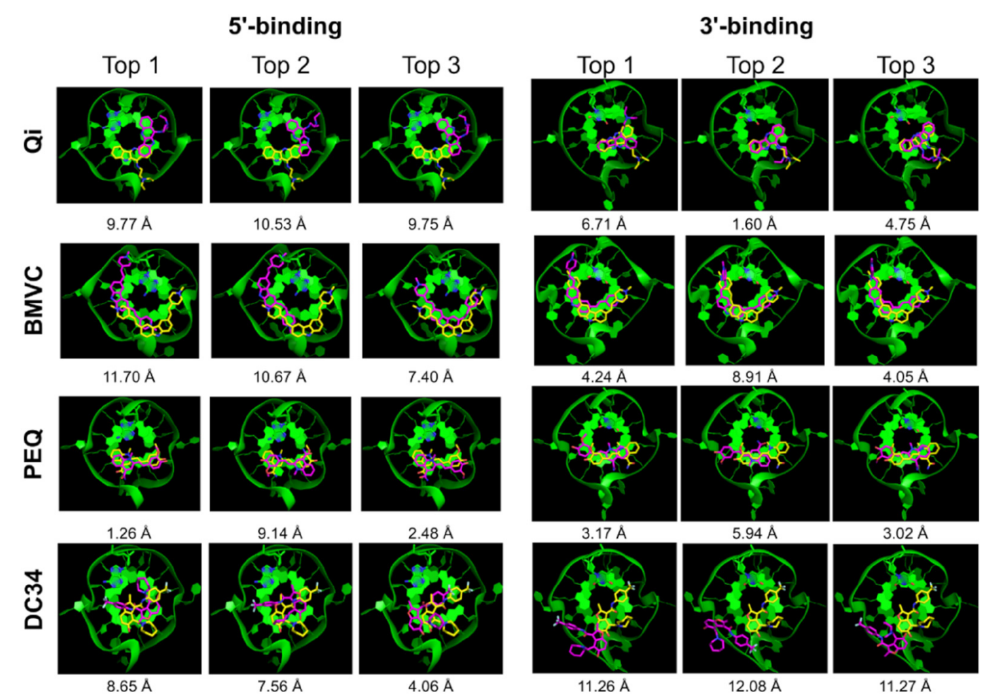
Figure 2. AutoDock Vina top 3 docked poses (purple) superimposed onto the NMR poses (yellow). The G4 DNA is shown as green